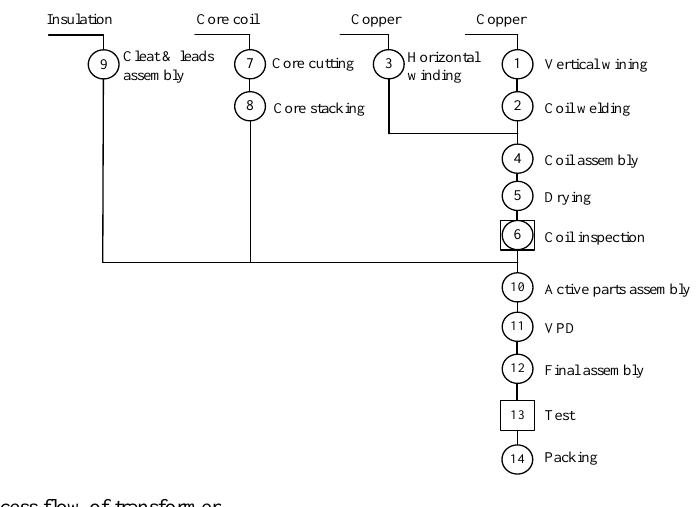
Fig.6. Process flow of transformer.